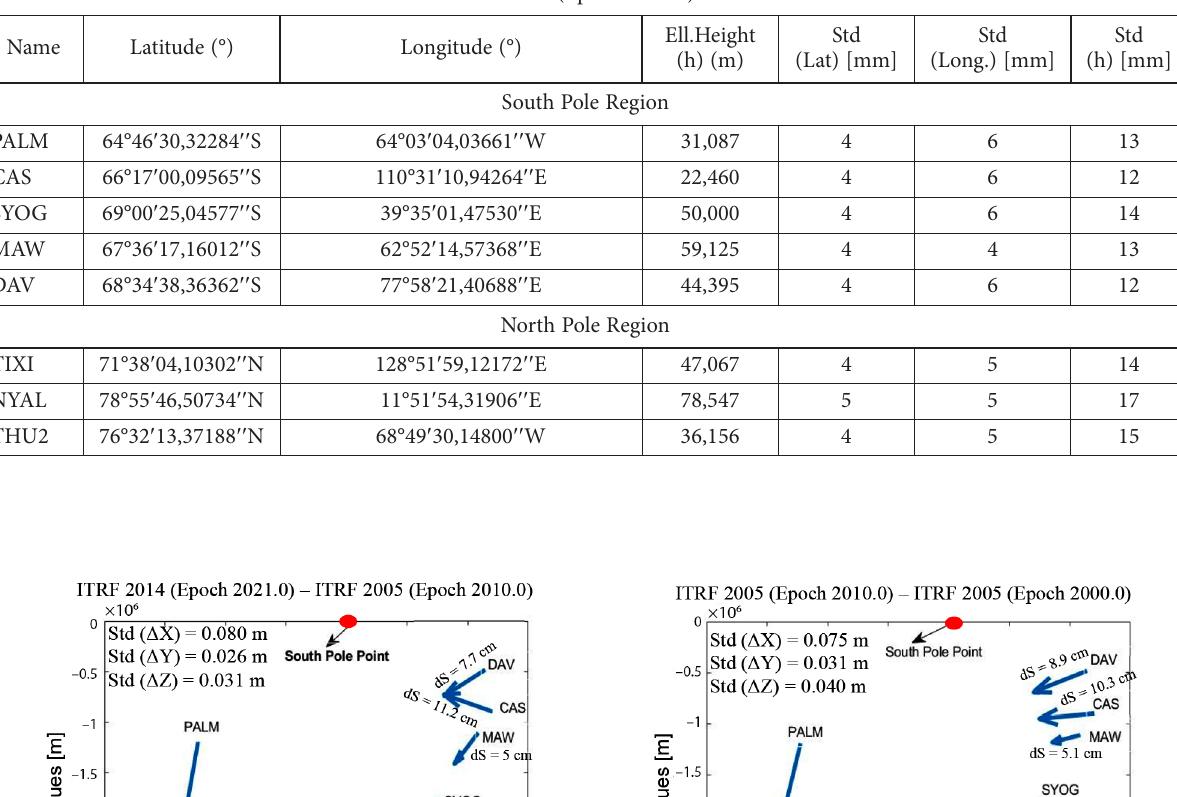
Table 2. Standard deviation and coordinate values (ITRF 05, Epoch 2010.0) of the eight IGS points by processing static GNSS satellites (CSRS-PPP Software) in the South and North Pole Region ITRF 05 (Epoch 2010.0)